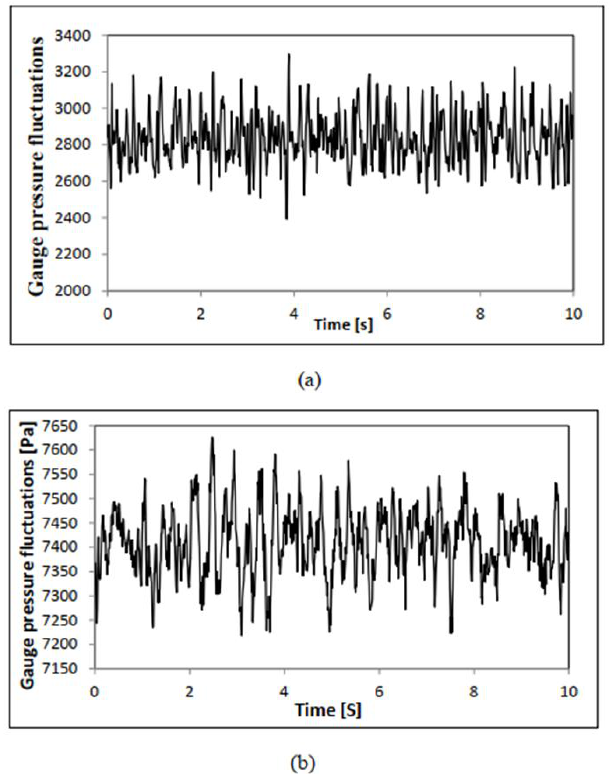
Figure 15. Gauge Pressure Fluctuations for Matching Conditions ( a ) (Case 2) in 0.14 m ID and ( b ) (Case 1) in 0.44 m ID Fluidized Beds at Axial Height (H/D = 1.7).